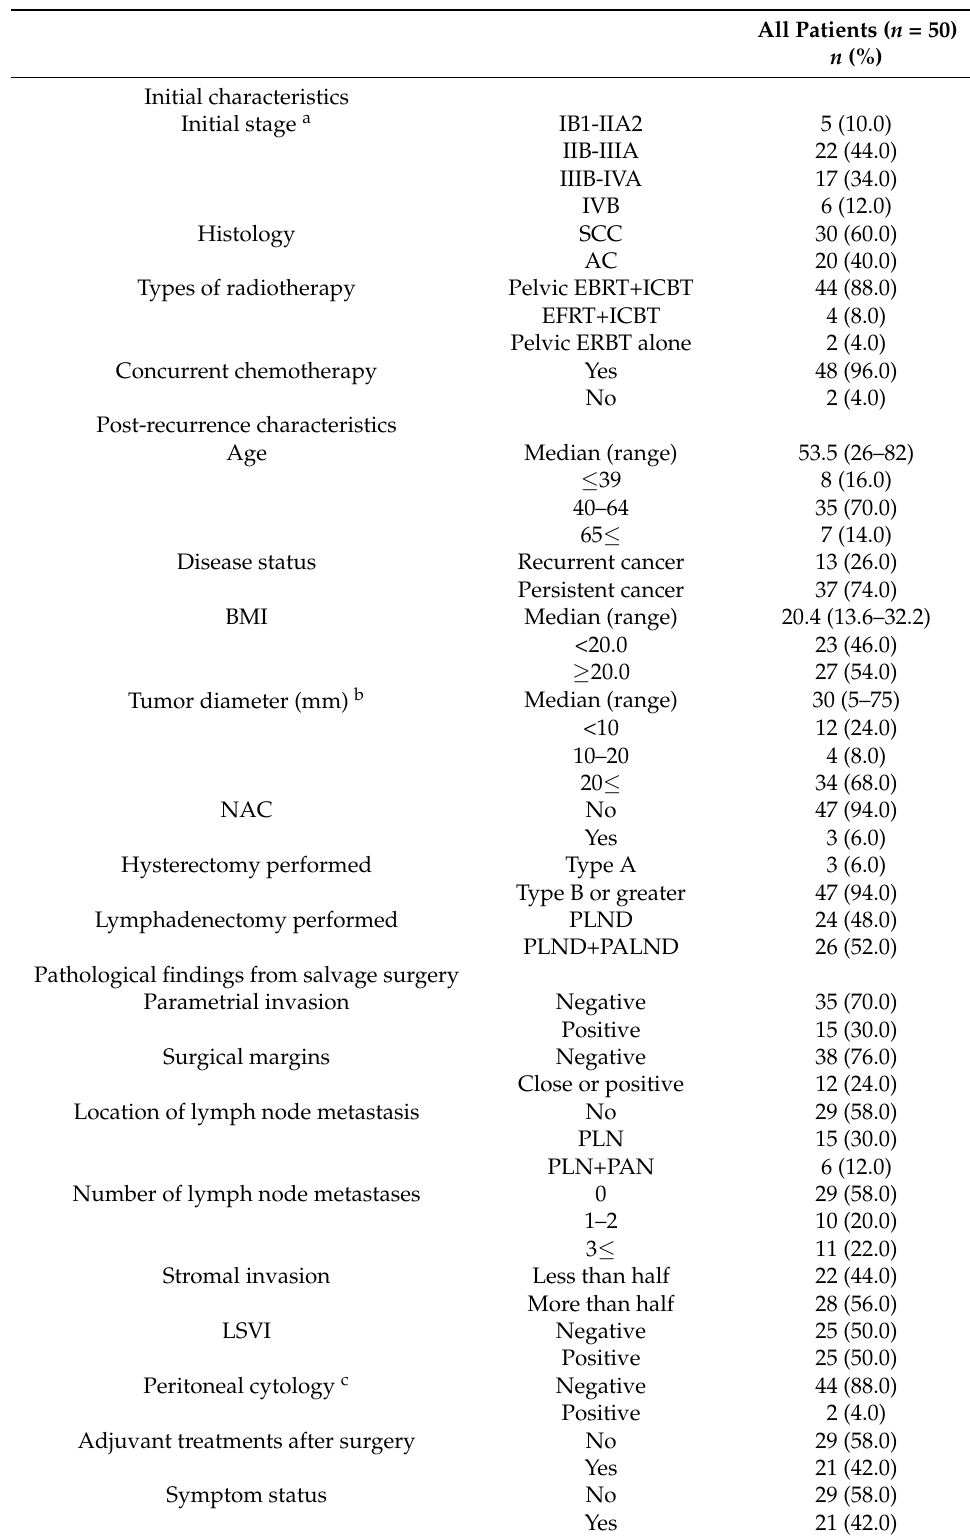
Table 1. Clinicopathological characteristics of the